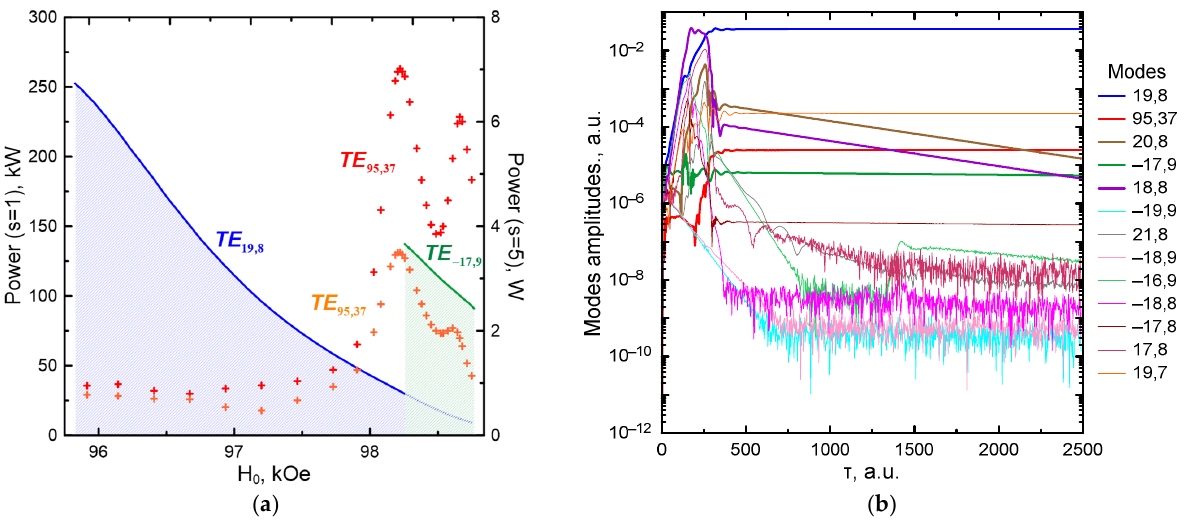
Figure 2. ( a ) Results of simulations for the 5th harmonic multiplication. Output power vs. guiding magnetic field for competing TE 19,8 and TE −17,9 modes at the 1st cyclotron harmonic and for TE 95,37 mode at the 5th cyclotron harmonic. Orange symbols depict the dependence of output power for the spread of electron velocities of 15%. ( b ) Establishment of the stationary oscillations in the process of competition between 12 modes at the fundamental cyclotron resonance.